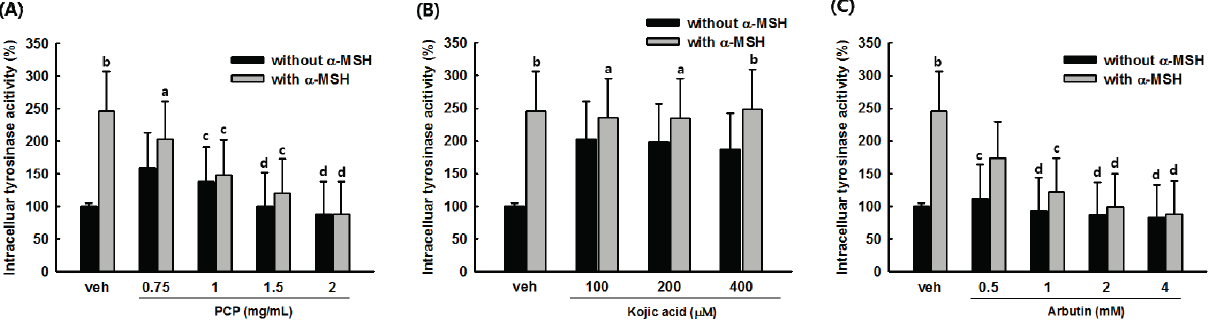
Figure 4. Effects of PCP on tyrosinase activity in B16F10 cells. ( A ) Tyrosinase